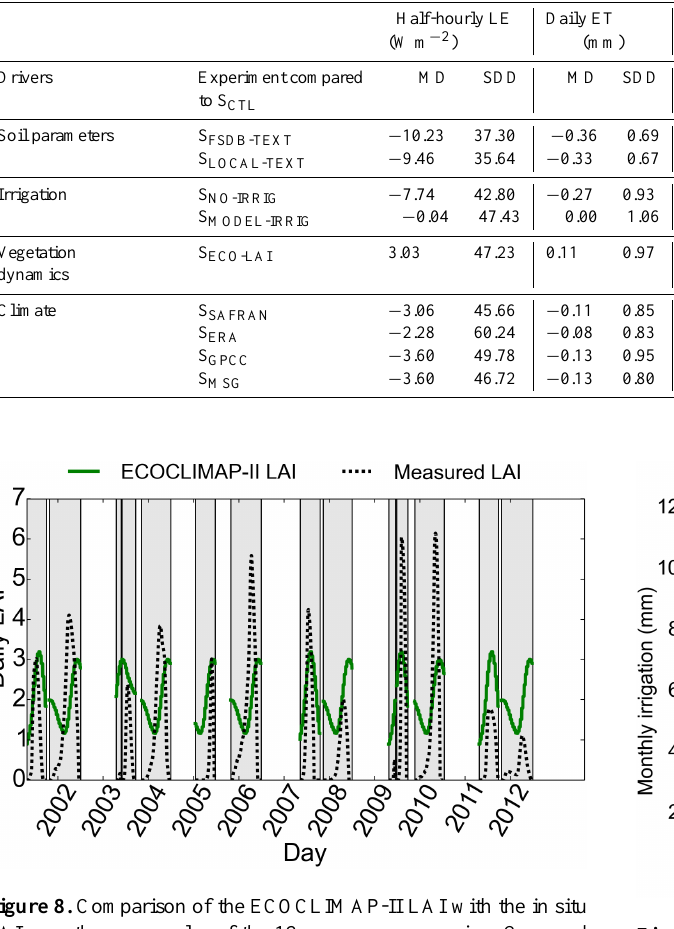
Figure 9. Comparison of the local and simulated mean monthly cumulative irrigation amount. The vertical bars represent the inter- annual variability ( ± 1 standard deviation). The total cumulative value of in situ and simulated irrigation over 12 years are 1295 and 2070mm,